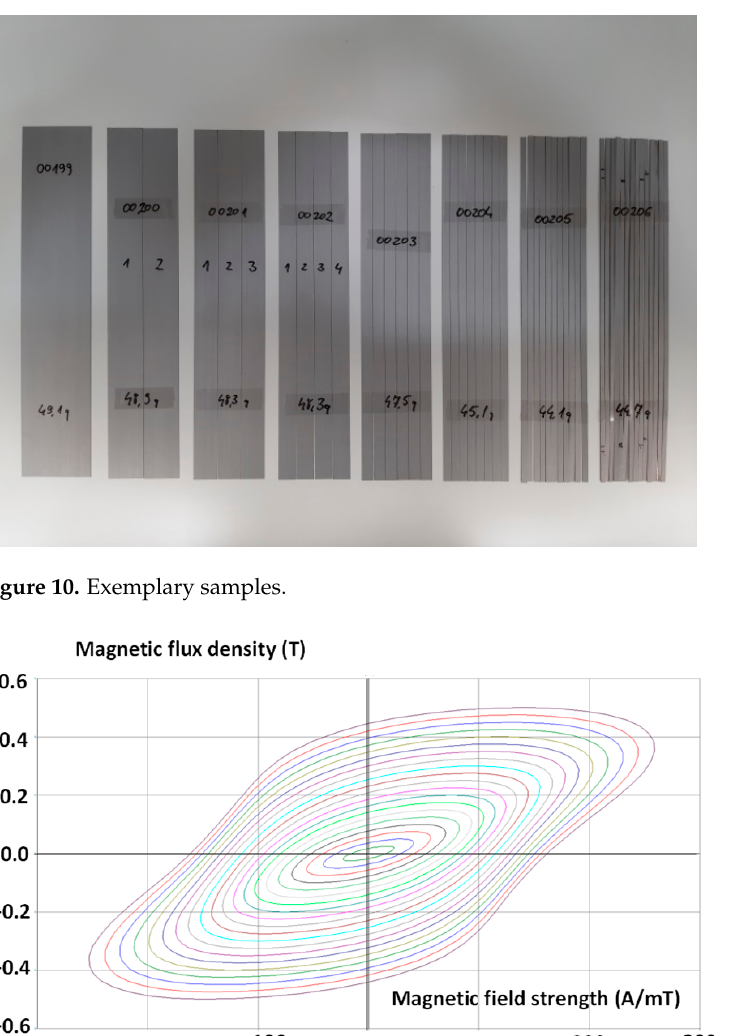
Figure 11. Exemplary measured hysteresis loop family.